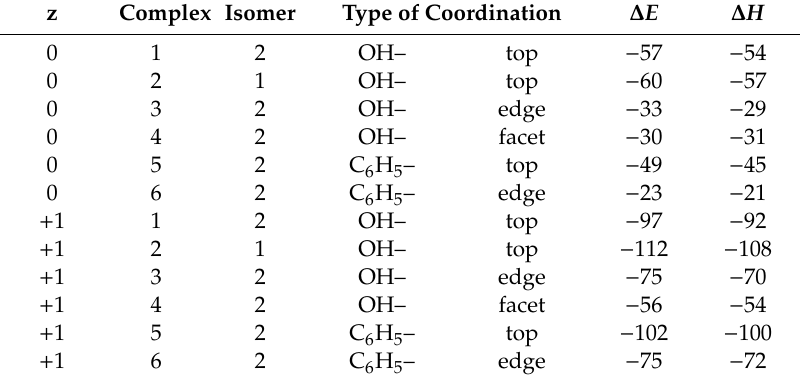
Table 9. The calculated values of the energy change ( ∆ E , kJ / mol) and standard enthalpy ( ∆ H , kJ / mol) in the reactions of 1-phenylethanol (1) or of 2-phenylethanol (2) with the Au 20z cluster (z = 0, + 1). z Complex Isomer Type of Coordination ∆ E ∆